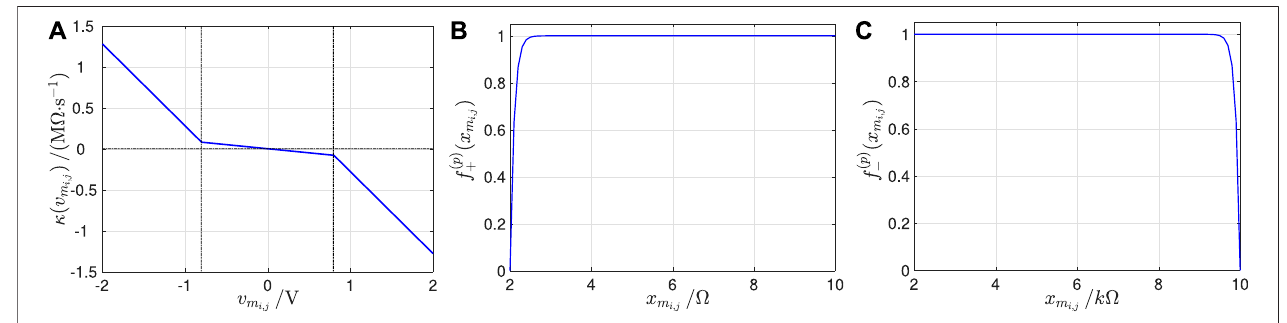
) as a function of v α (cid:1) 10 5 Ω · V − 1 s − 1 , β (cid:1) 10 6 Ω · V − 1 s − 1 , and V m i , j for i , j